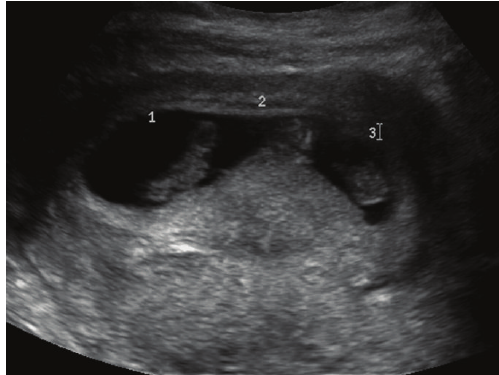
Figure 1: Three gestational sacs in the 5th week of gestation. Figure 2: The monozygotic (monochorionic triamniotic) triplets in the 7th